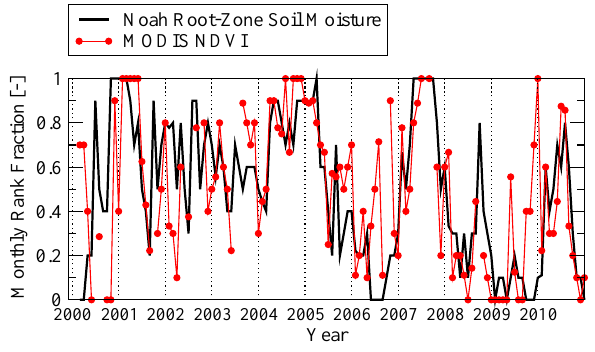
Fig. 1. Example monthly Rank ( NDVI ) and Rank ( ¯ θ Noah ) time se- ries for a 0.25 ◦ pixel in the South Central United States. A rank of zero (one) means that a given month has a lower (higher) soil mois- ture/NDVI than all other occurrences of its month of the year within the 2000–2010 time